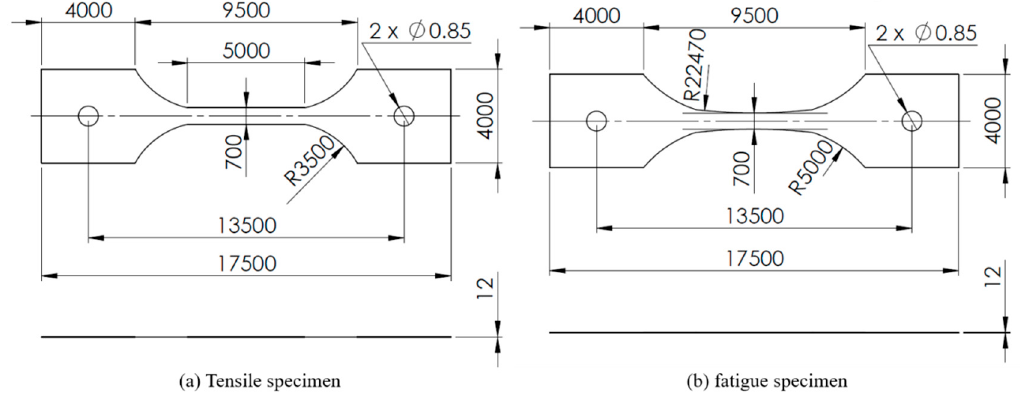
Figure 1. The shape and dimension of the specimens ( μ m). ( a ) Tensile specimen ( b ) Fatigue specimen.